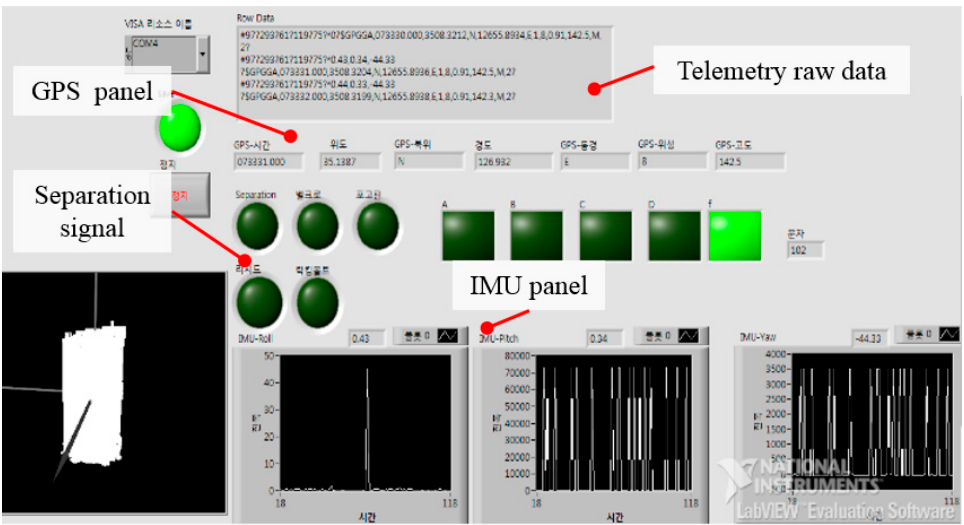
Figure 9. Captured monitor view of the software developed for the DHRM CanSat ground